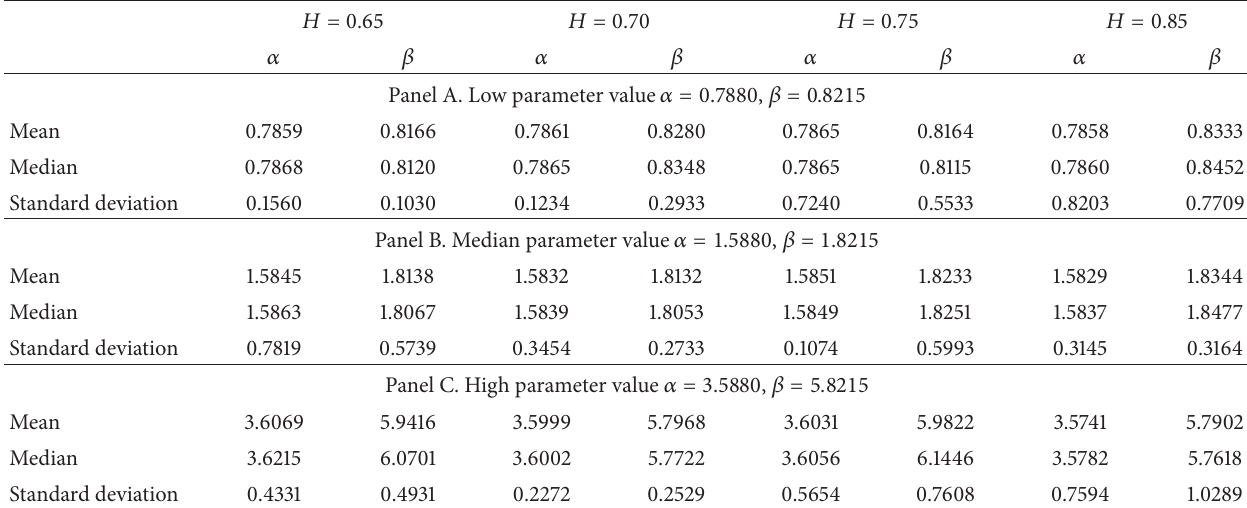
Table 1: The means and standard deviations of the